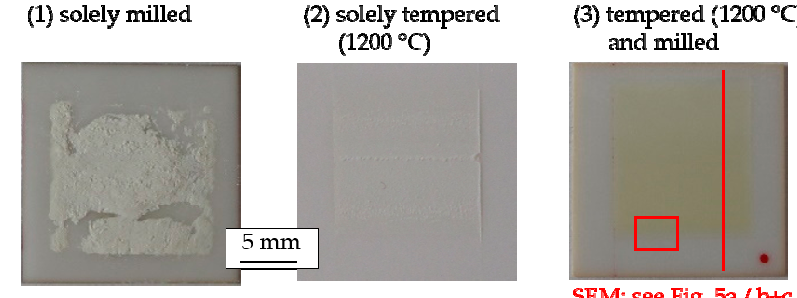
Figure 3. Optical quality of aerosol-deposited GDC10 films when differently pretreated powders were used: ( 1 ) Solely milled; ( 2 ) solely tempered at T PT = 1200 °C; and ( 3 ) tempered at T PT = 1200 °C and subsequently milled. The comparable images use identical scales.